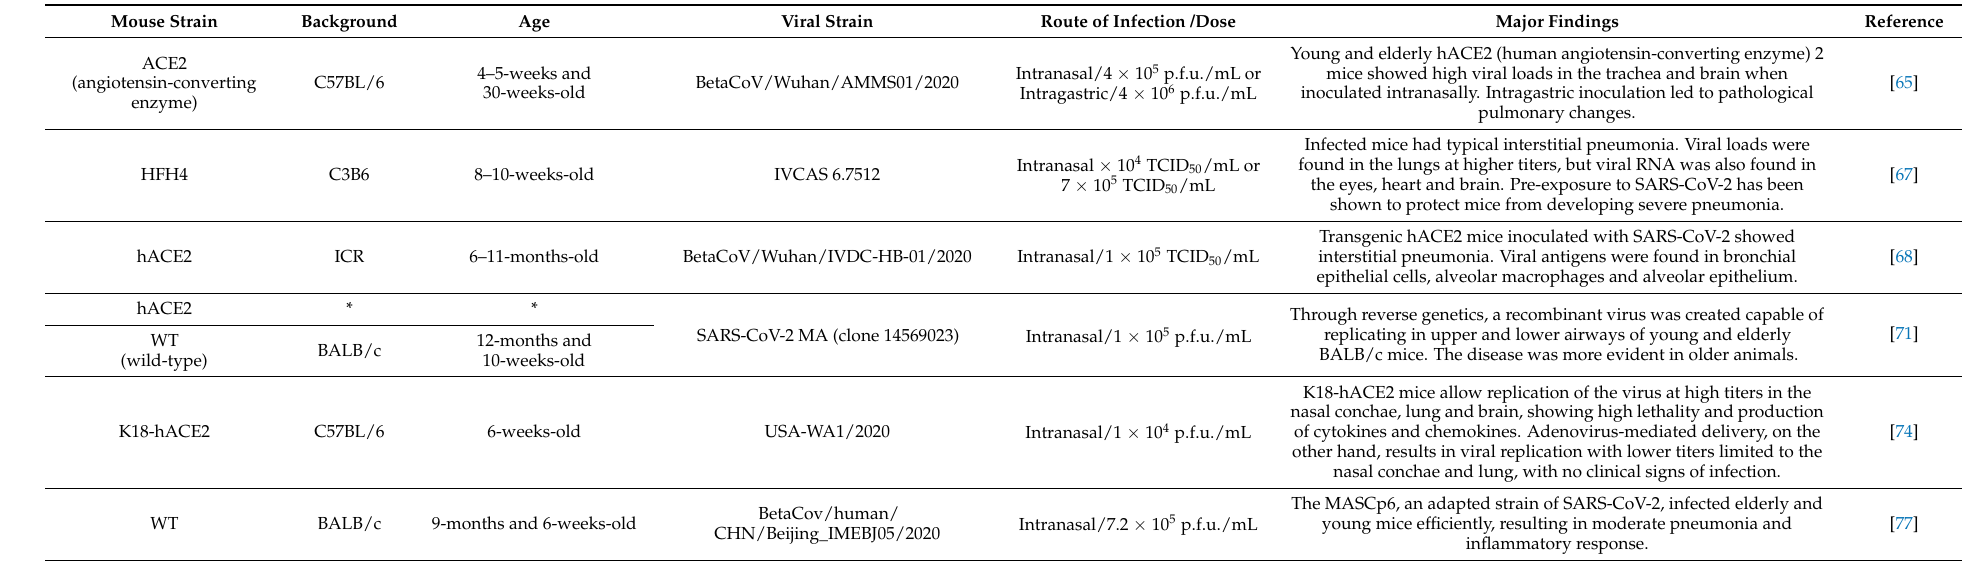
Table 2. Mouse models used in SARS-CoV-2